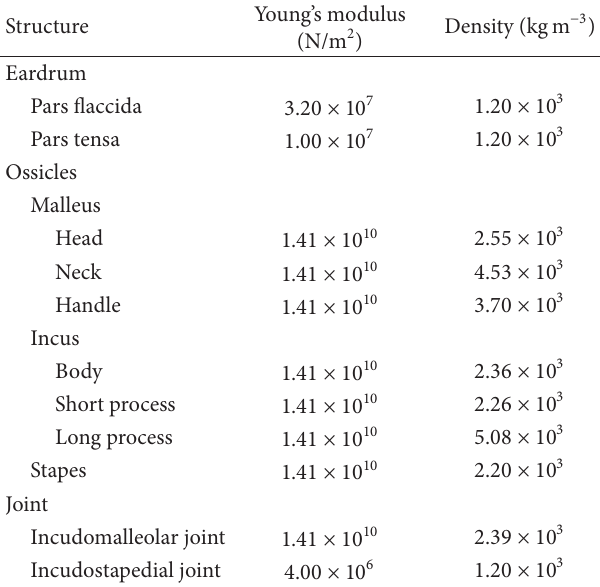
Table 1: Material properties of the ear components.